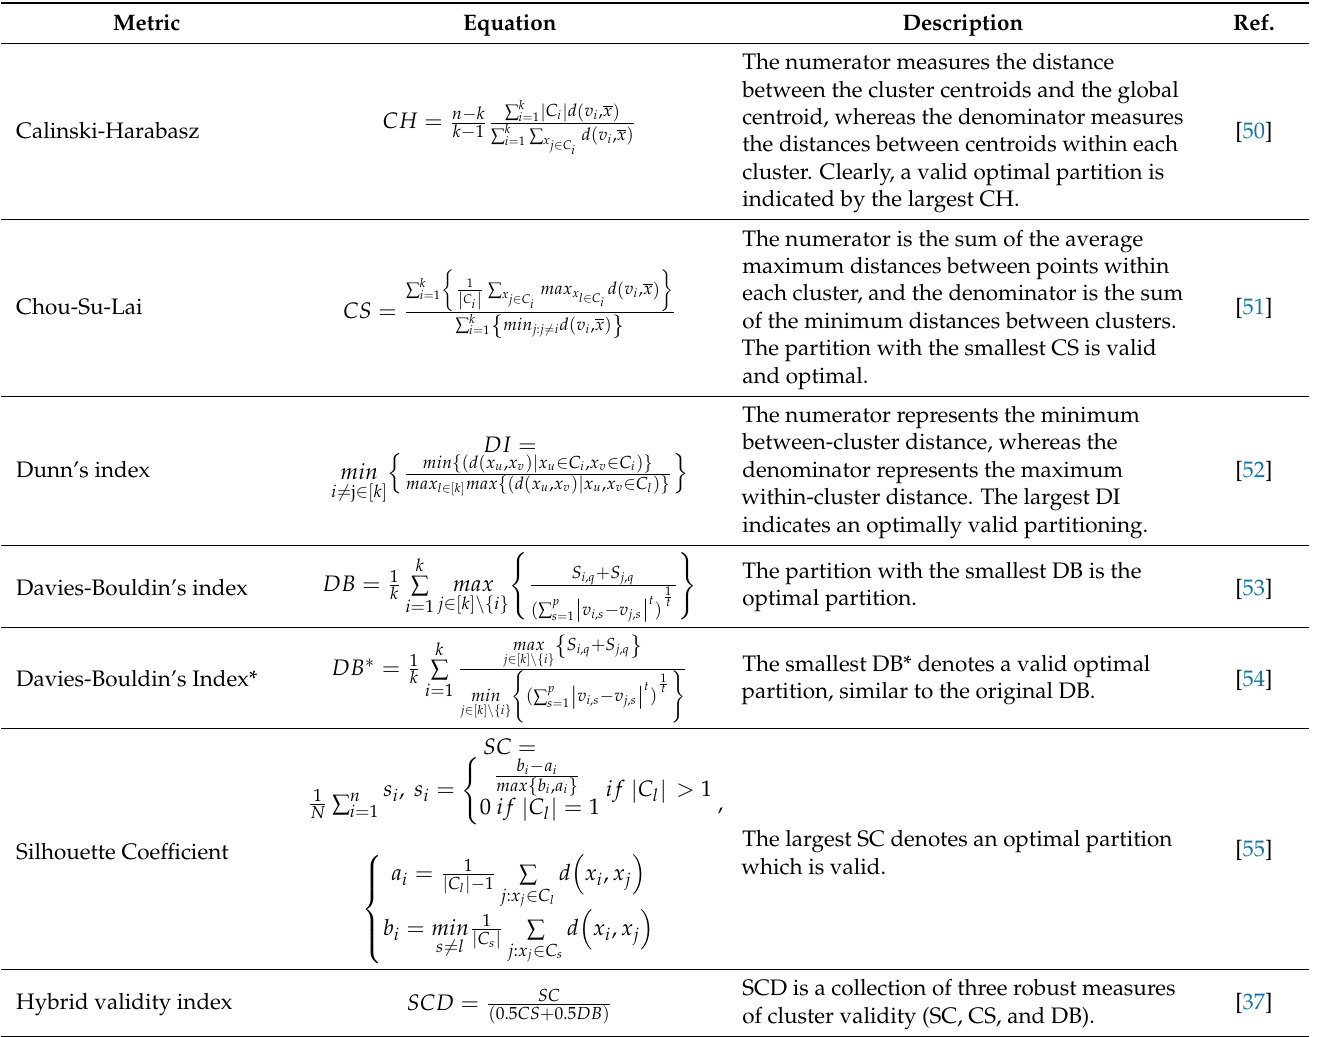
Table 5. Common error functions in